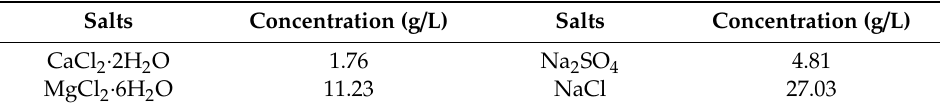
Table 1. Synthetic seawater recipe.